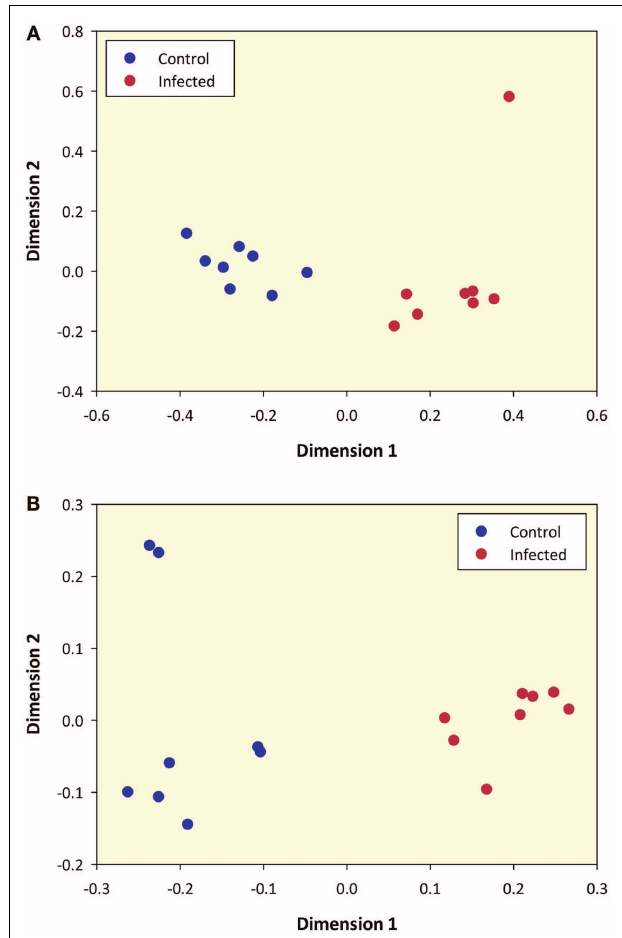
FIGURE 1 | Multidimensional scaling plot of M. bovis -infected and control samples based on RNA-seq sense data and microarray data . (A) MDS plot of 8 M. bovis -infected and 8 control PBL samples generated from 12,294 genes that passed all data filtering prior to differential gene expression (based on RNA-seq sense data only). (B) MDS plot using data from 5,082 informative microarray probe sets in 8 M. bovis -infected and 8 control PBL